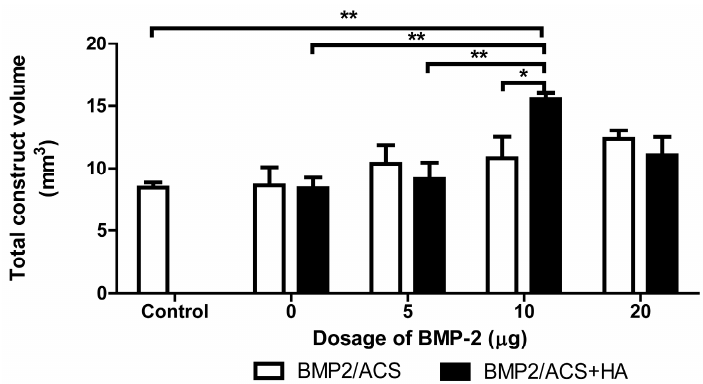
Figure 2. Mean volumes of newly formed bone tissue in the BMP-2/ACS constructs, in the presence or absence of 100 µ g/mL HA (48 kDa) implanted at different BMP-2 dosages, 18 days after implant placement. Values represent means ± SEM; n = 6 per experimental group. The asterisks denote the level of statistical significance, i.e., * p < 0.05. The compared groups are indicated by brackets. The total construct volumes did not significantly differ among the groups without HA (Figure 3).